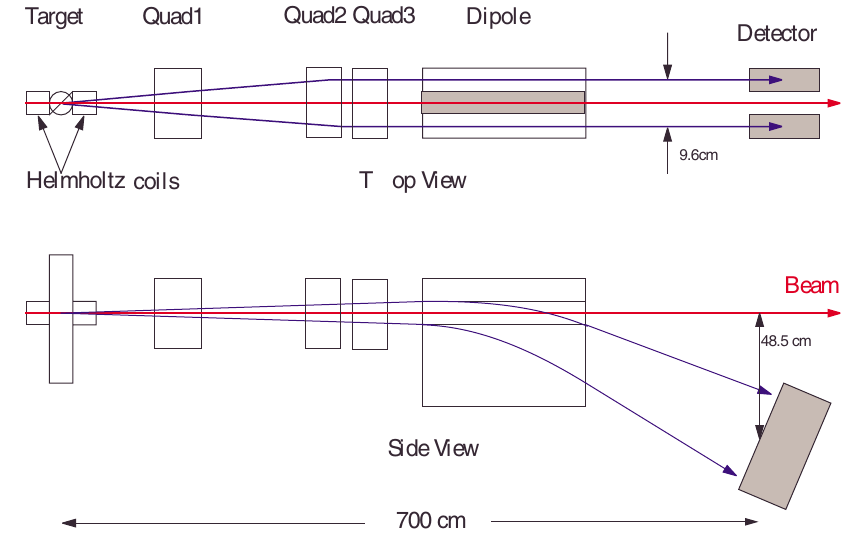
FIG. 4. (Color) Schematic of the Hall A Møller